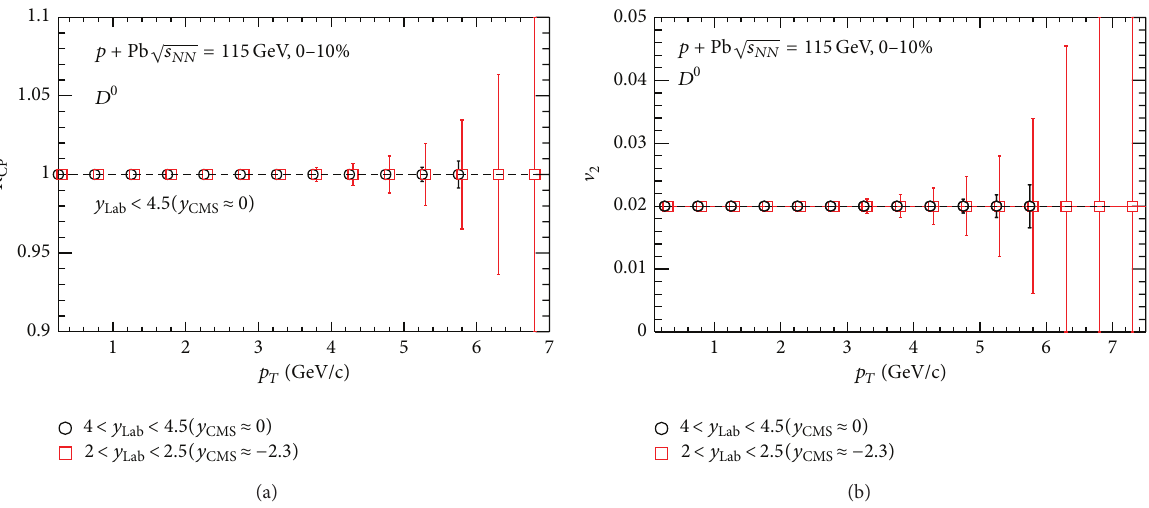
Figure 8: Expected statistical uncertainties of (a) 𝐷 0 𝑅 CP and (b) 𝐷 0 elliptic flow in 𝑝 + Pb collisions at √ 𝑠 𝑁𝑁 = 115GeV.